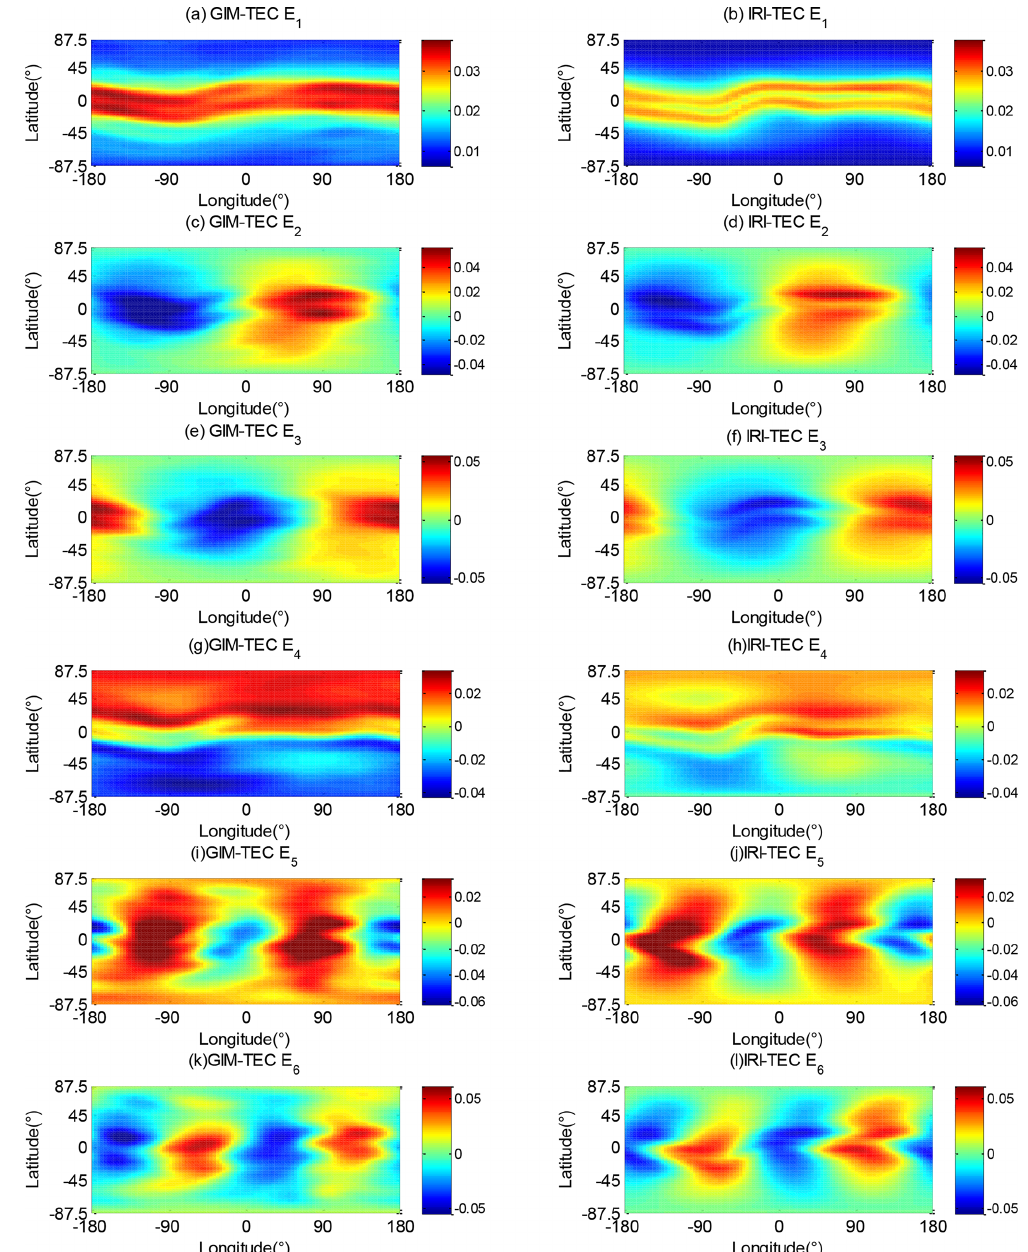
Figure 5. First six orders of EOF base functions E 1 – E 6 extracted on the basis of Eq. (6). The figures in the left column are the base functions of GIM-TEC, and those in the right column are the base functions of